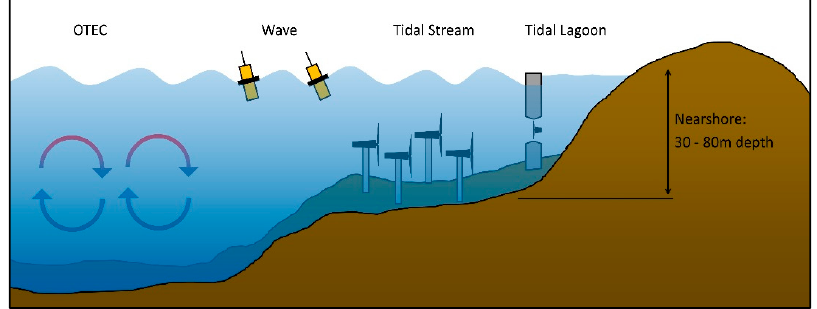
Figure 1. Marine energy technologies: ocean thermal energy conversion (OTEC), wave, tidal stream and tidal lagoon. and tidal